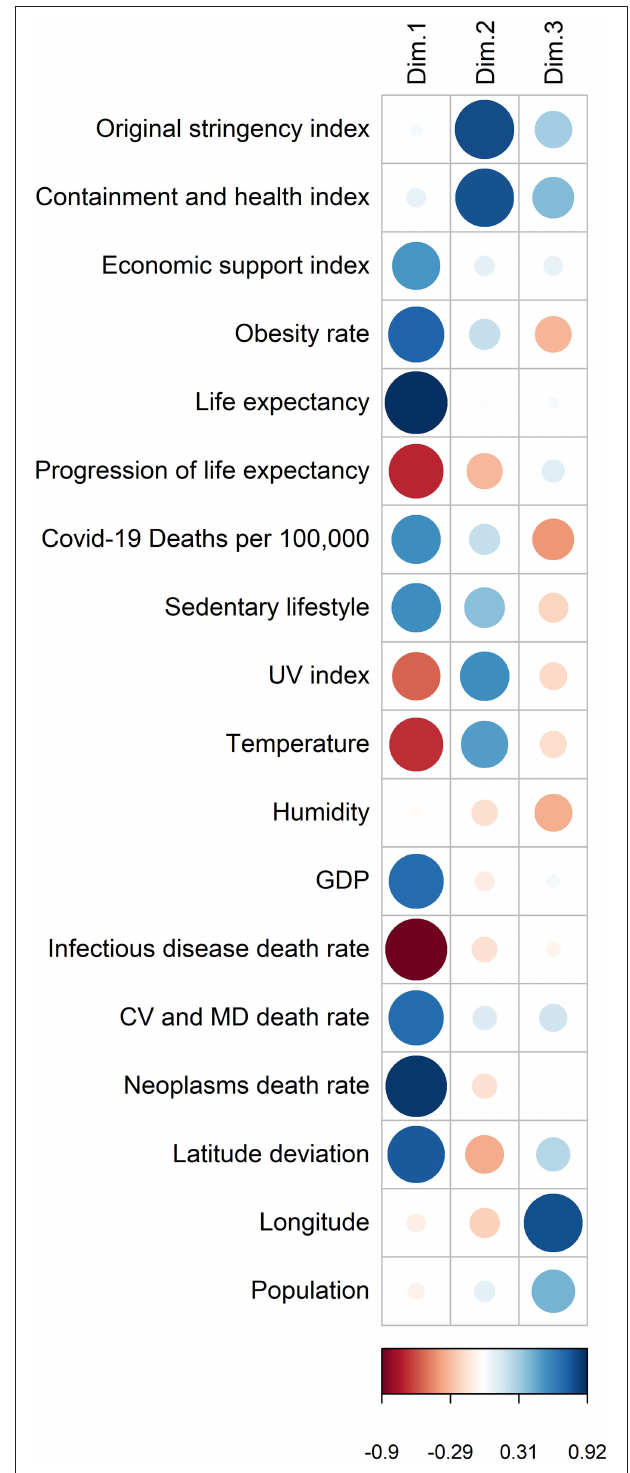
FIGURE 4 | Coordinates of the variables on the first 3 factorial axes. The larger the circle, the more the variable is correlated with the axis. A blue circle indicates that the variable is negatively correlated, a red circle indicates that the variable is positively correlated. The scale shows the coordinates of the variables on the